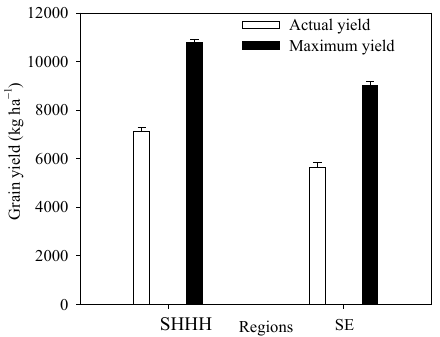
Figure 7. The actual yield and stimulated maximum yield in SHHH and SE regions. Lower planting density induced lower RUE, TUE, and PUE values. Reasonably in- creasing the planting density was an effective agronomic measure for enhancing the re- source utilization efficiency of maize. In this study, D4 and D5 treatments had higher RUE, TUE, and PUE values than other treatments, which was similar to previous findings [48].